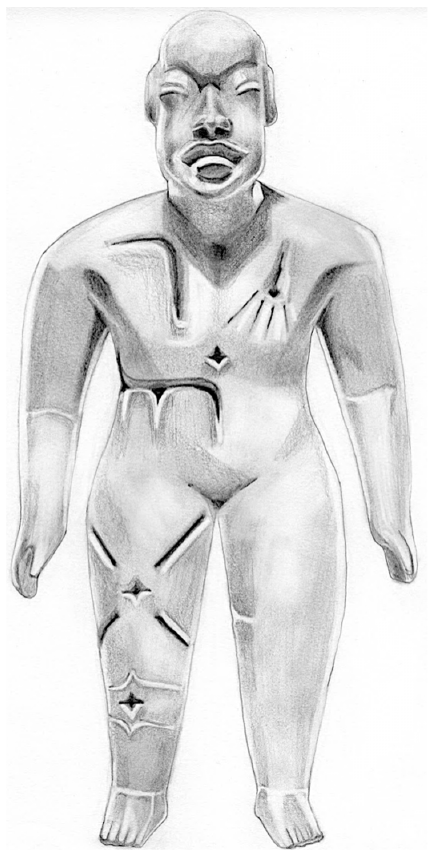
Figure 7. A rendition of the female clay-figurine from Las Bocas in the Valley of Mexico (see Guthrie 1995, p. 314) showing multiple forms of night and early morning imagery. We see stars, comets, and full constellations. Among these are the Venus Star. Such pieces of pottery represented both planting guides, and precious gifts, shared among early Mesoamerican people. Drawing by 2nd